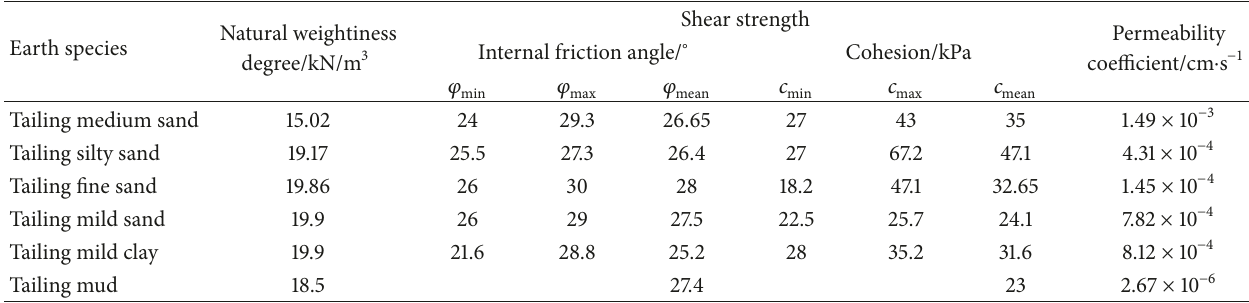
Figure 3: Cross section map of tailing dam of Hengyang. The ZK1 to ZK5 are the sampling holes. The legends show the constituents of the tailings. The tailings consist of tailing medium sand, tailing silty sand, tailing fine sand, tailing mild sand, tailing mild clay, and tailing mud. The distances between sampling holes are noted below the graph. Table 1: The physical and mechanical parameters of the tailing dam.